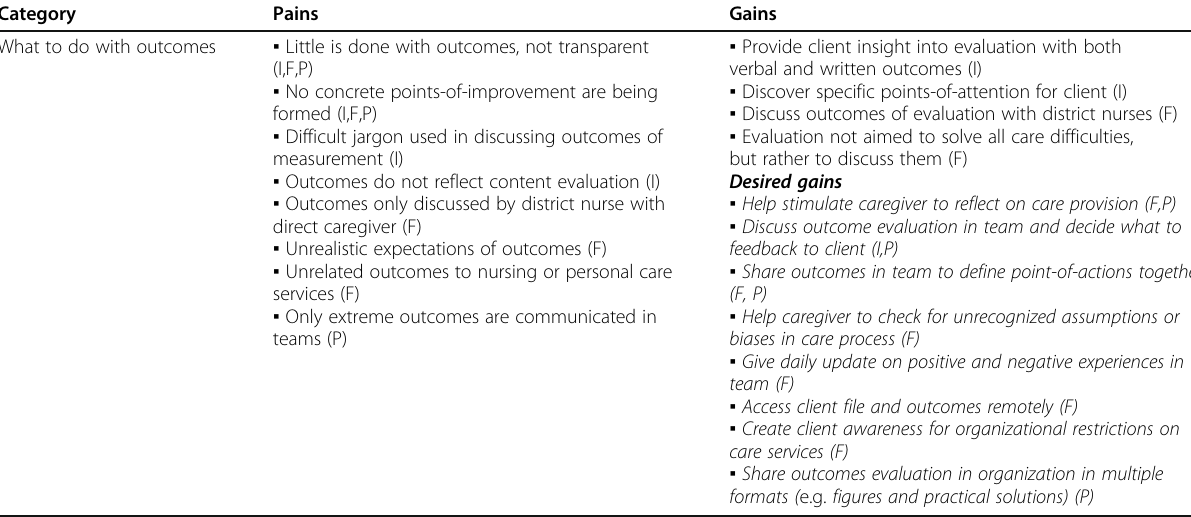
Table 7 Identified pains and (desired) gains for ‘ what to do with outcomes ’ Category Pains Gains What to do with outcomes ▪ Little is done with outcomes, not transparent (I,F,P)